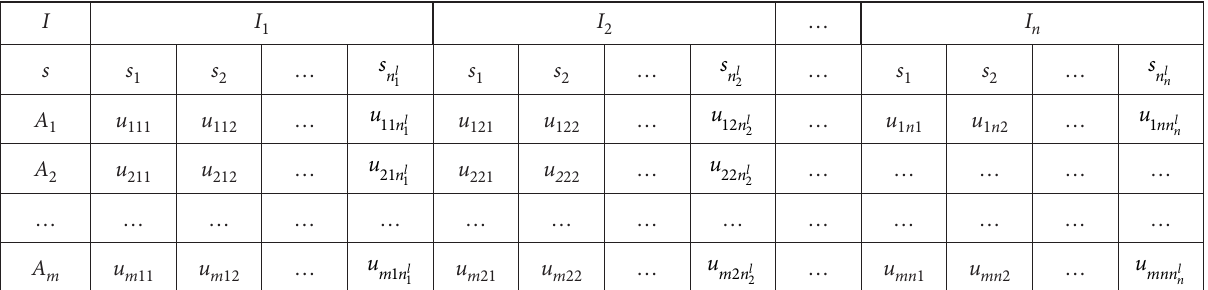
Table 1. The generalized MIMS